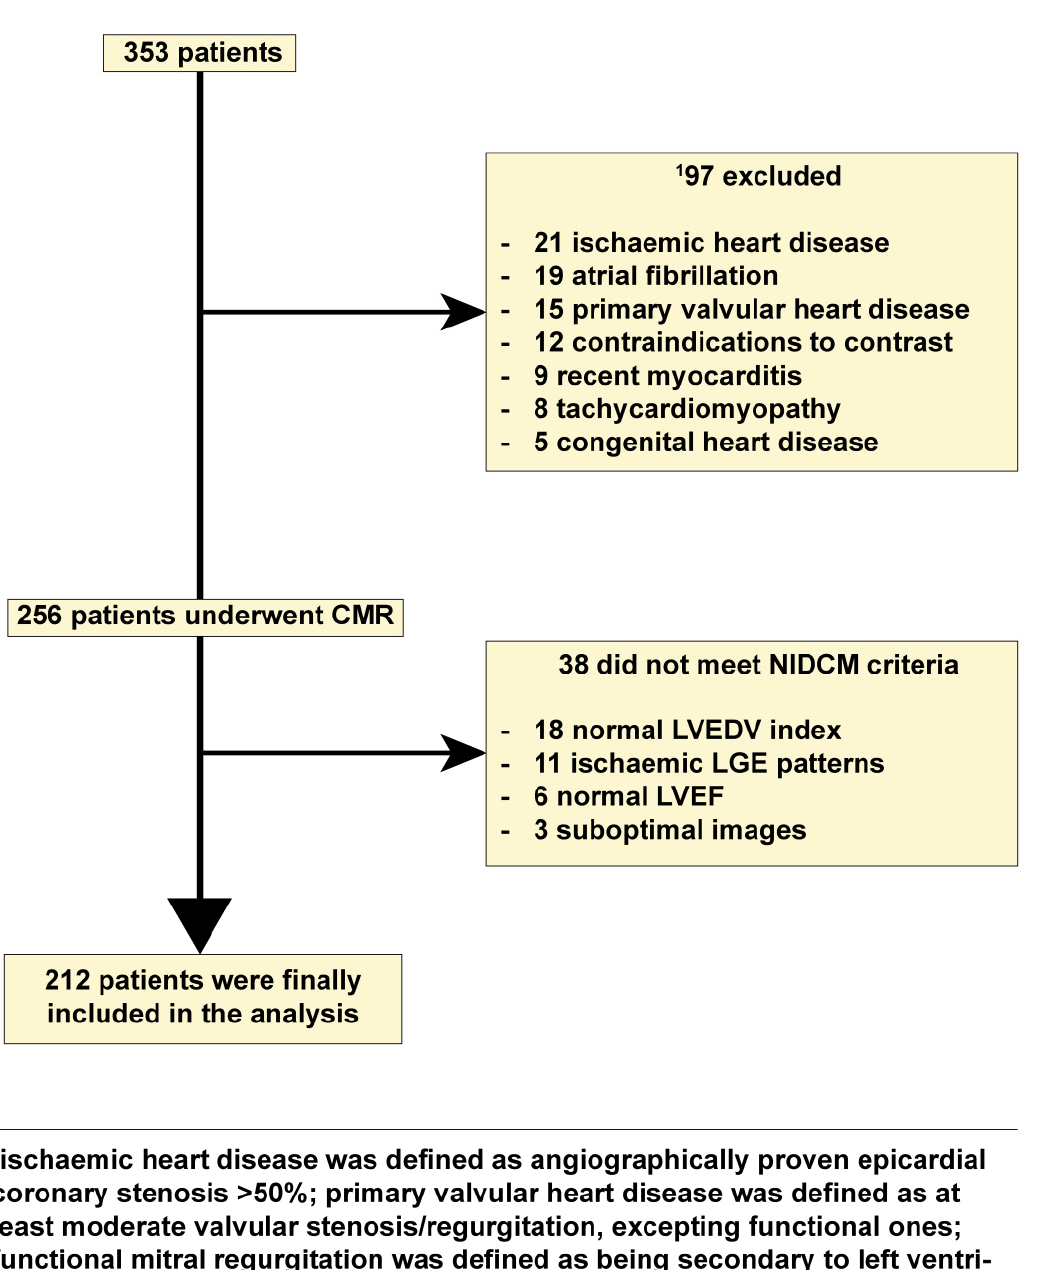
Figure 1. Flow chart detailing the study cohort. Abbreviations: CMR, cardiac magnetic resonance imaging; LGE, late gadolinium enhancement; NIDCM, nonischemic dilated cardiomyopathy.